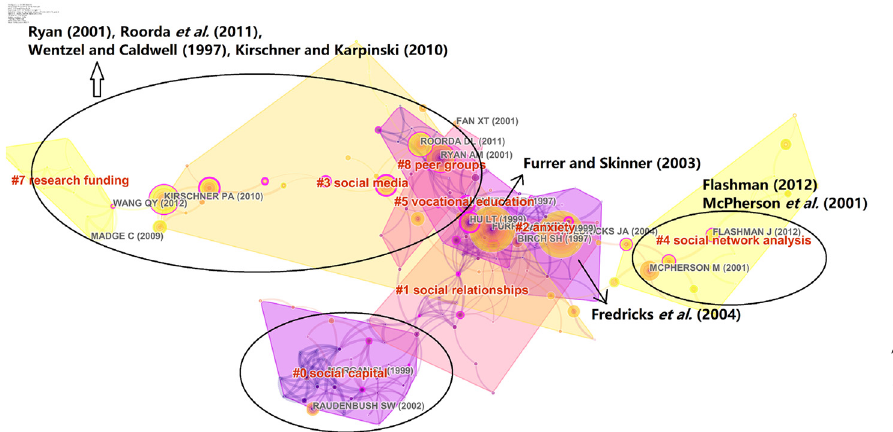
Figure 1. The merged network of path fi nder-pruned co-cited